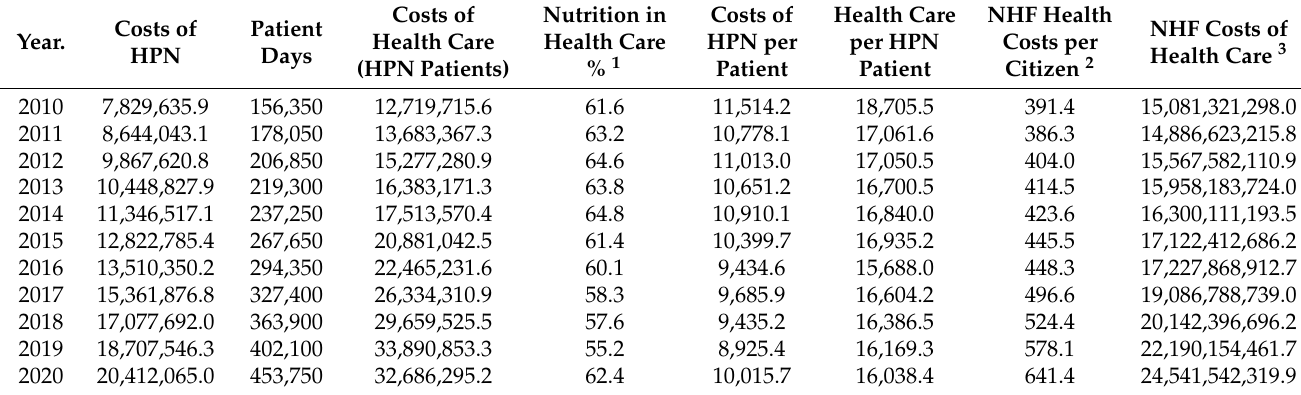
Table 2. Costs of HPN and total health care in Poland–NHF data.